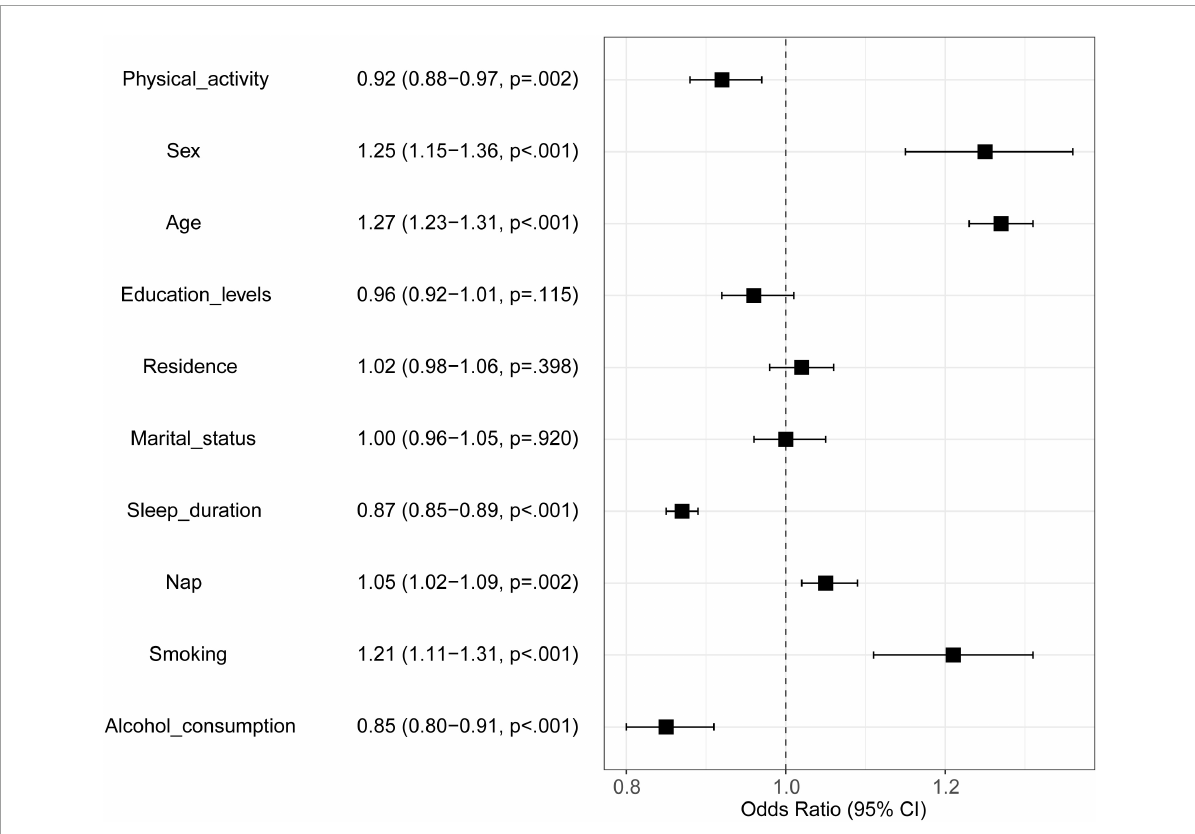
FIGURE1 Result of traditional logistic regression model. Black square represents Odds Ratio; the two ends of the square represent the 95% confidence interval (95% CI). If 95% CI crosses through the dotted line, it indicates that the corresponding variable is not correlated with